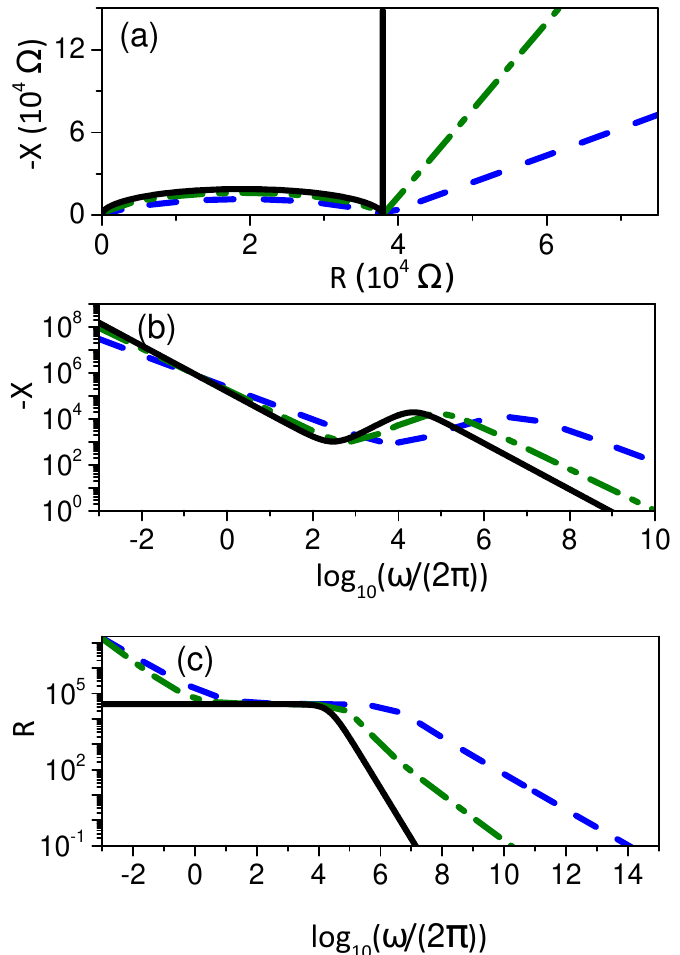
Figure 1. ( a ) Nyquist diagram for different values of γ , with Φ ( i ω ) = ( i ω ) γ , which implies p ( γ (cid:48) ) = δ ( γ (cid:48) − γ ) . ( b ) Imaginary part of the impedance for different values of γ . ( c ) R vs. ω in the same range of frequency. The black (solid), green (dotted), and blue (dashed) lines correspond to the cases γ = 1.0, γ = 0.9, and γ = 0.7, respectively. We consider, for illustrative purposes, D = 2.0 × 10 − 9 m 2 /s, S = 3.1415 × 10 − 4 m 2 , ε = 90 ε 0 ( ε 0 = 8.85 × 10 − 12 F/m), d = 1.33 × 10 − 3 m, τ = 1s, and λ = 1.19 × 10 − 7